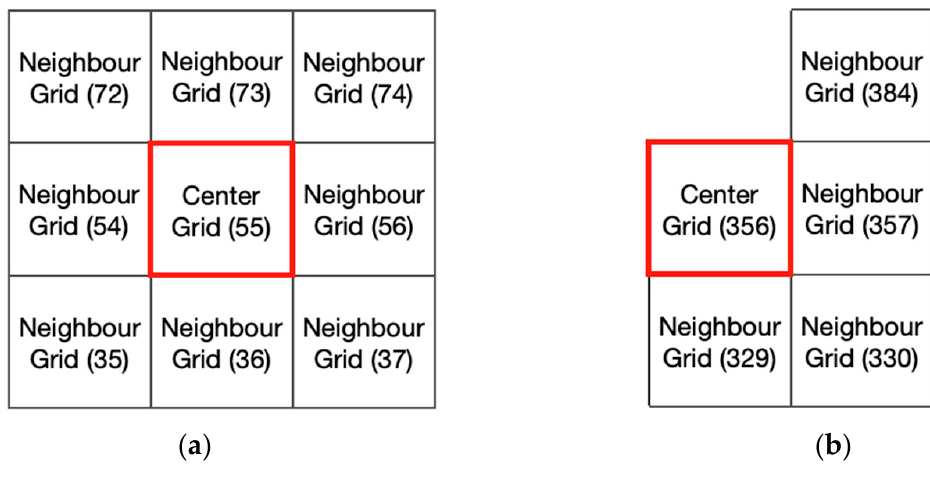
Figure 8. ( a ) Regular grid distribution; ( b ) irregular grid distribution.